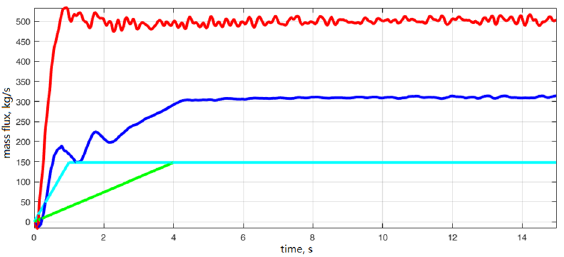
Figure 7. Flue–gas flow rate of tower A/B inlet section and recirculation flue inlet section (red: entrance to tower A; blue: entrance to tower B; turquoise: recirculation flue section of tower A; green: recirculation flue section of tower B).